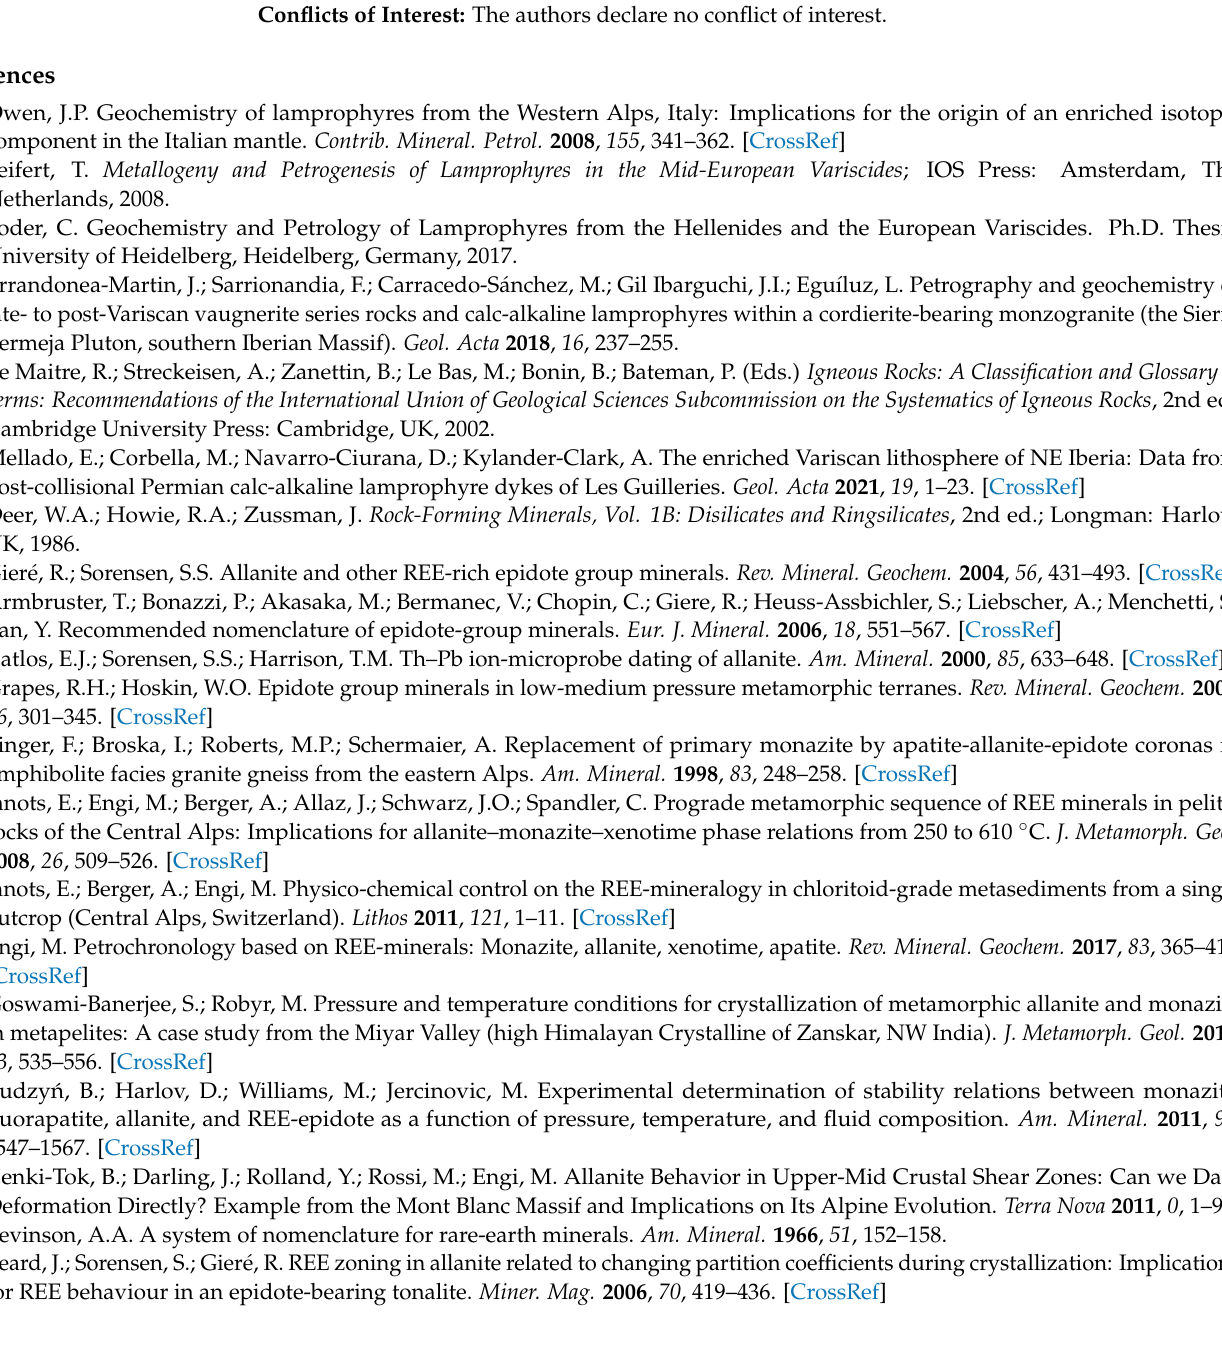
Table S2: Allanite chemical data from